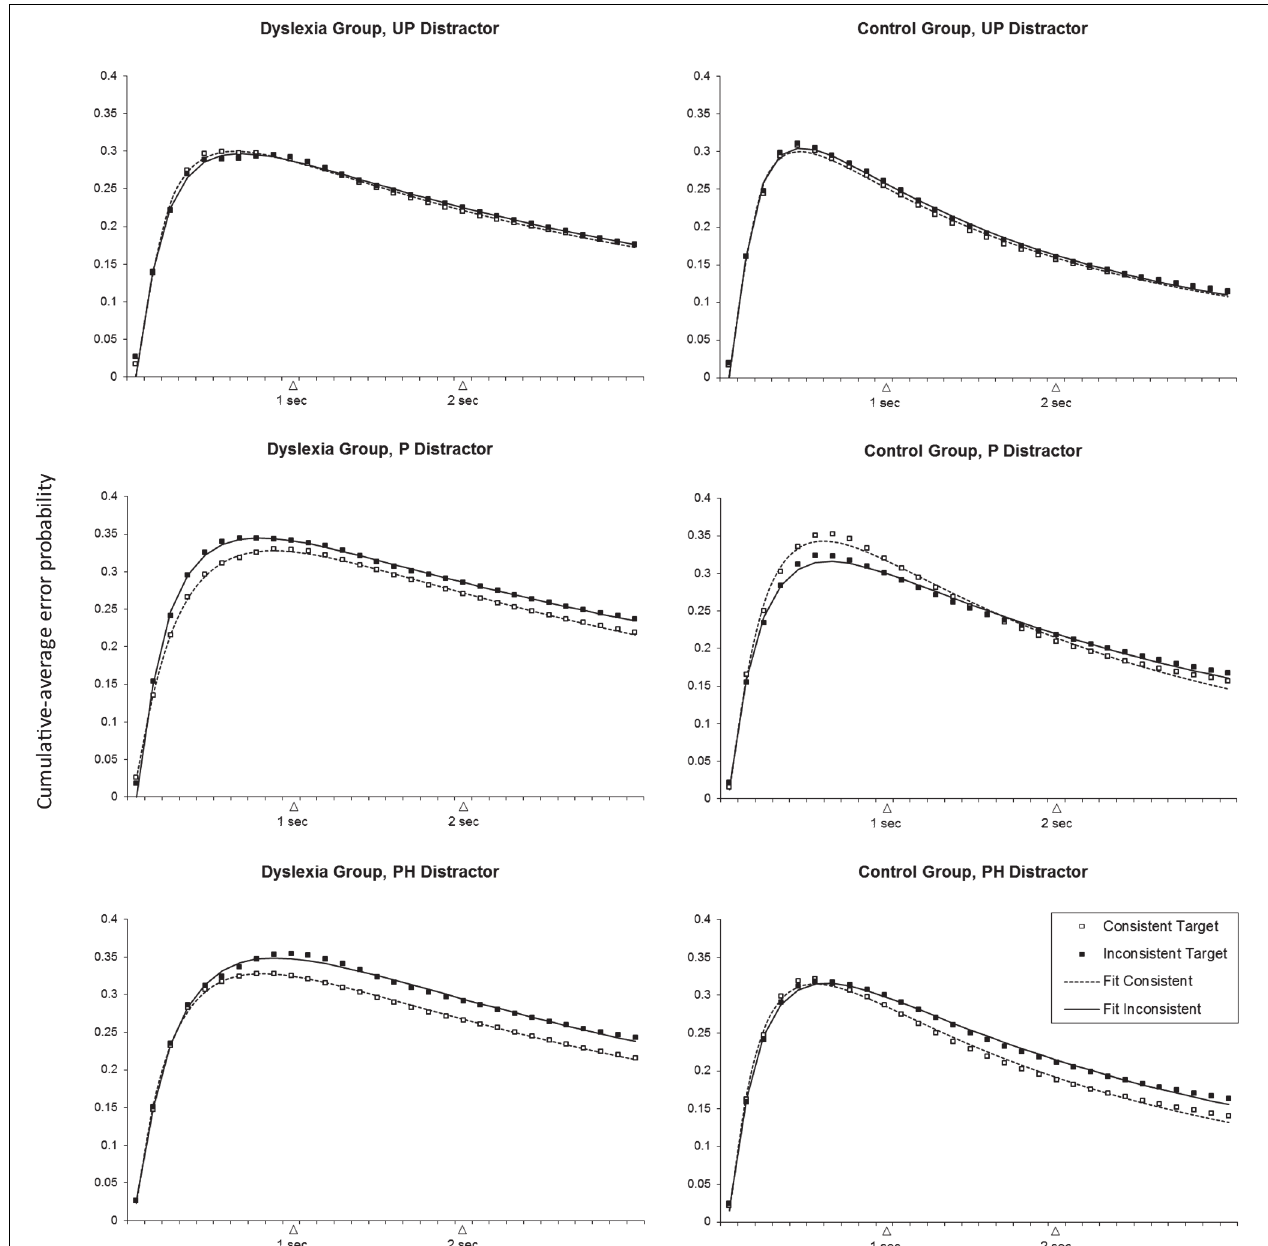
FIGURE 4 | Cumulative-average error probabilities over time (10Hz sampling rate) in each condition. Panels at the left show data for the Dyslexia group, panels at the right for the Control group. From top to bottom: UP, unpronounceable; P, pronounceable; PH, pseudohomophone distractor